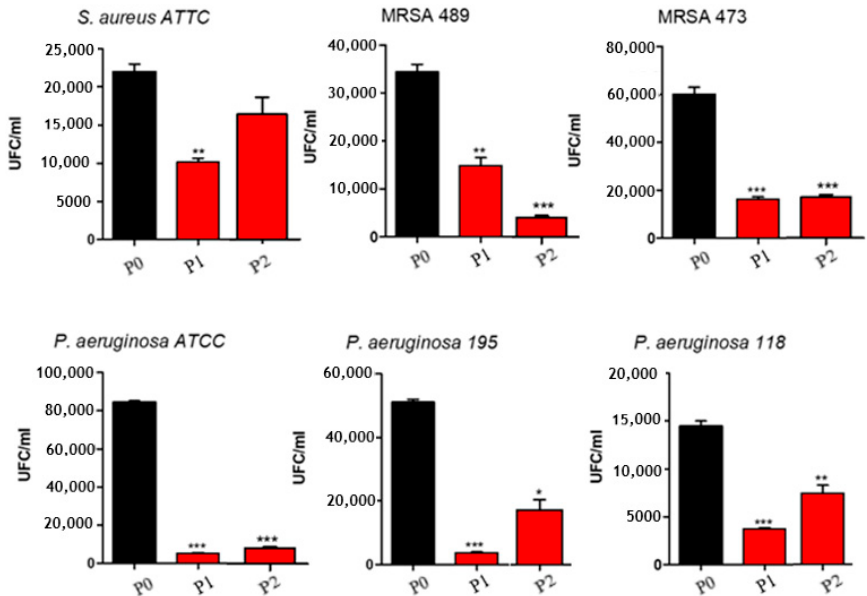
Figure 10. Strains adherence of S. aureus and P. aeruginosa (ATCC, clinical isolates) to polylactic acid films; *, ** and *** correspond to the magnitude of antimicrobial activity.